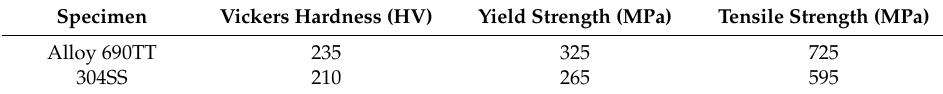
Table 2. Mechanical properties of the